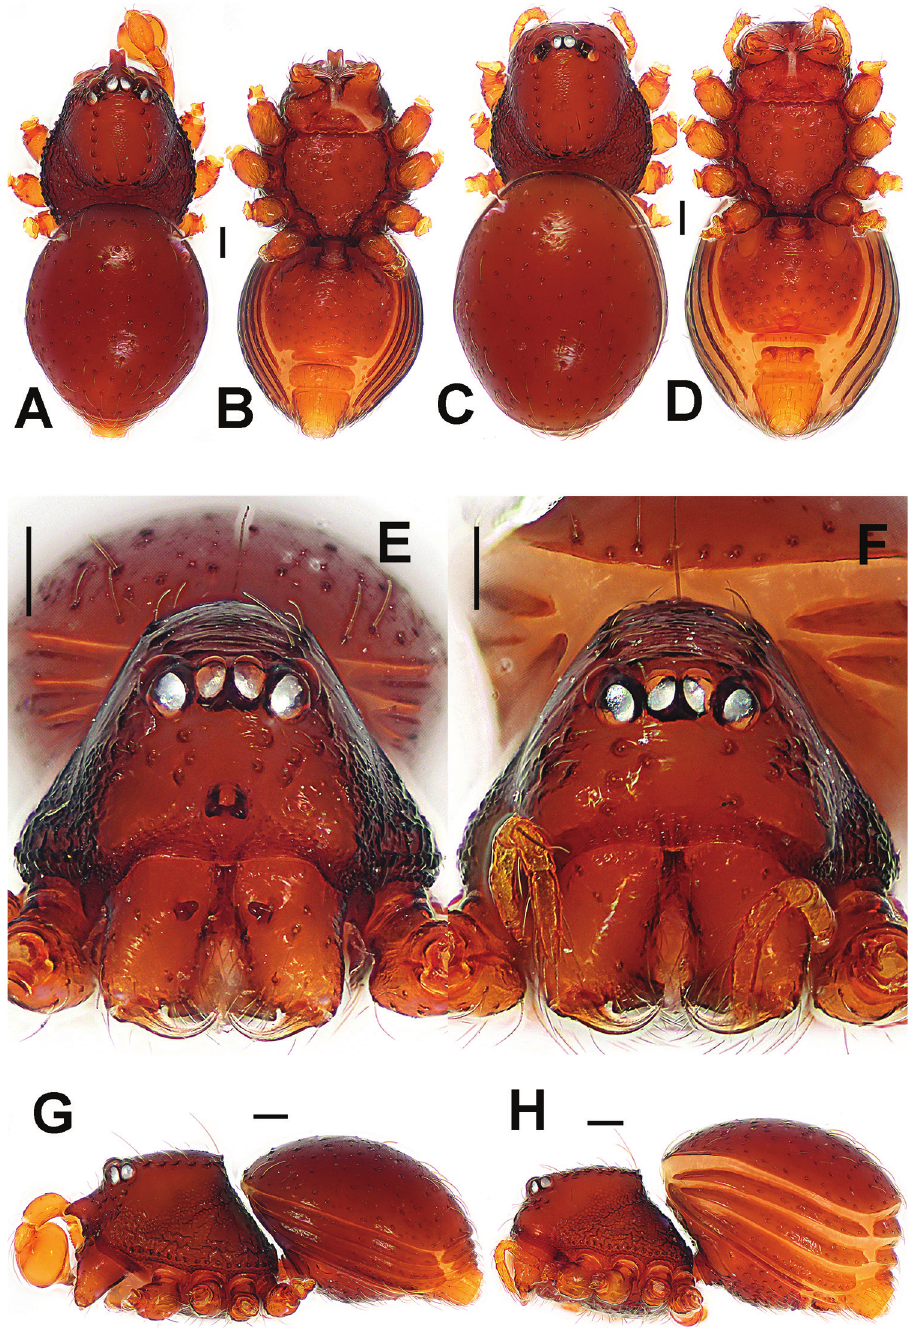
Figure 10. Brignoliella besutensis Lin, Li & Jäger, 2012, male ( A–B, E, G ) and female ( C–D, F, H ) from Singapore. A–D, G–H habitus E–F prosoma. A, C dorsal B, D ventral E–F anterior G–H lateral. Scale bars: 0.10